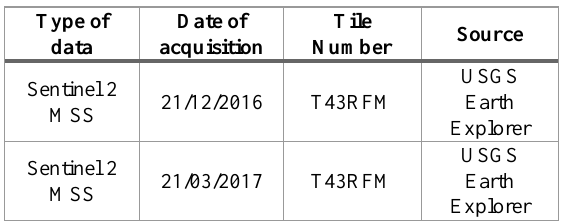
Fig 5: Sentinel 2 MSS (21/12/2016)